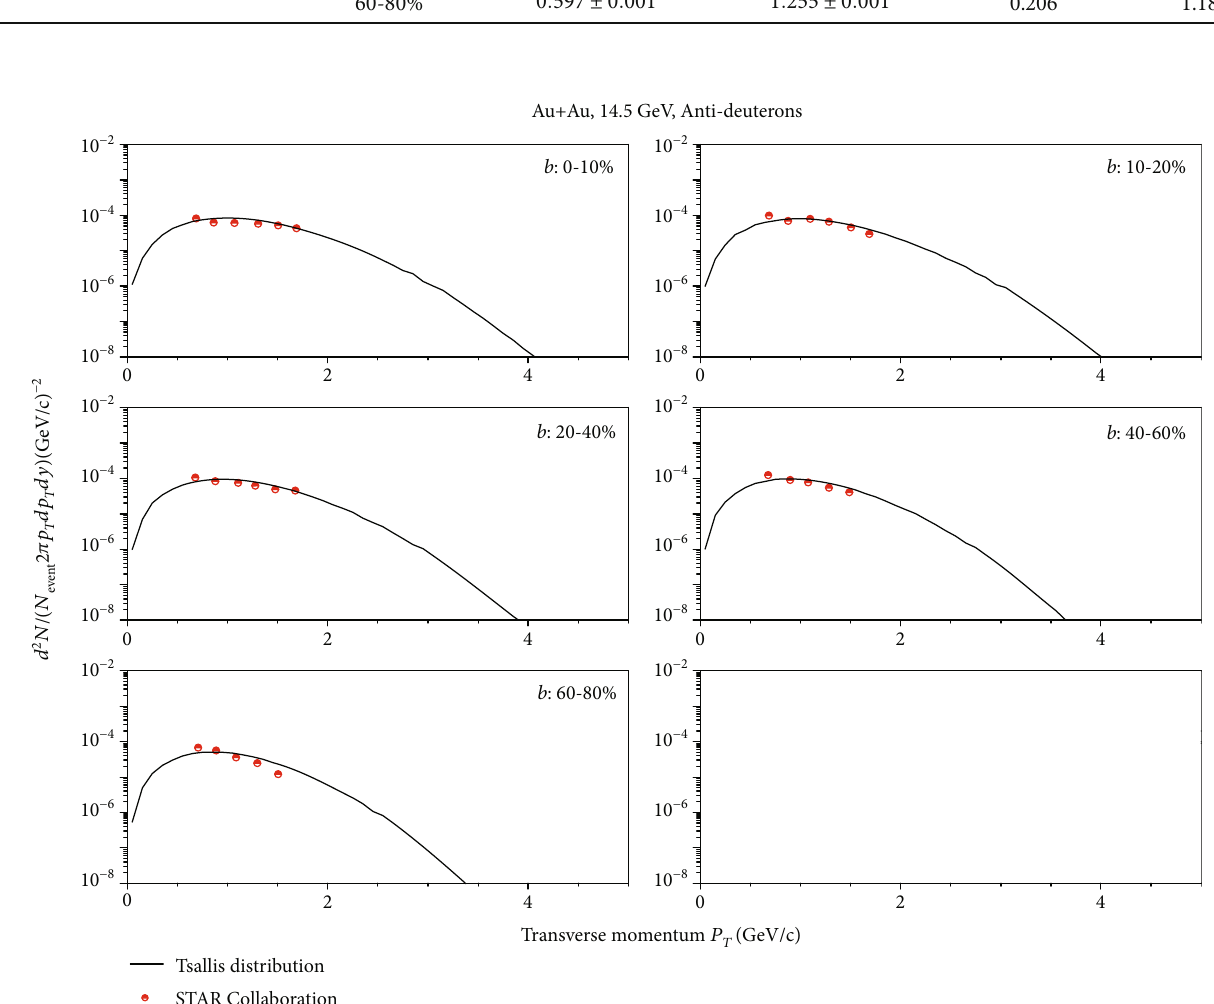
Figure 4: Antideuteron transverse momentum spectra in Au+ Au collisions at 60-80% centralities. Calculations are shown by the solid lines. Experimental data taken from the STAR Collaboration [20] are represented by the symbols.